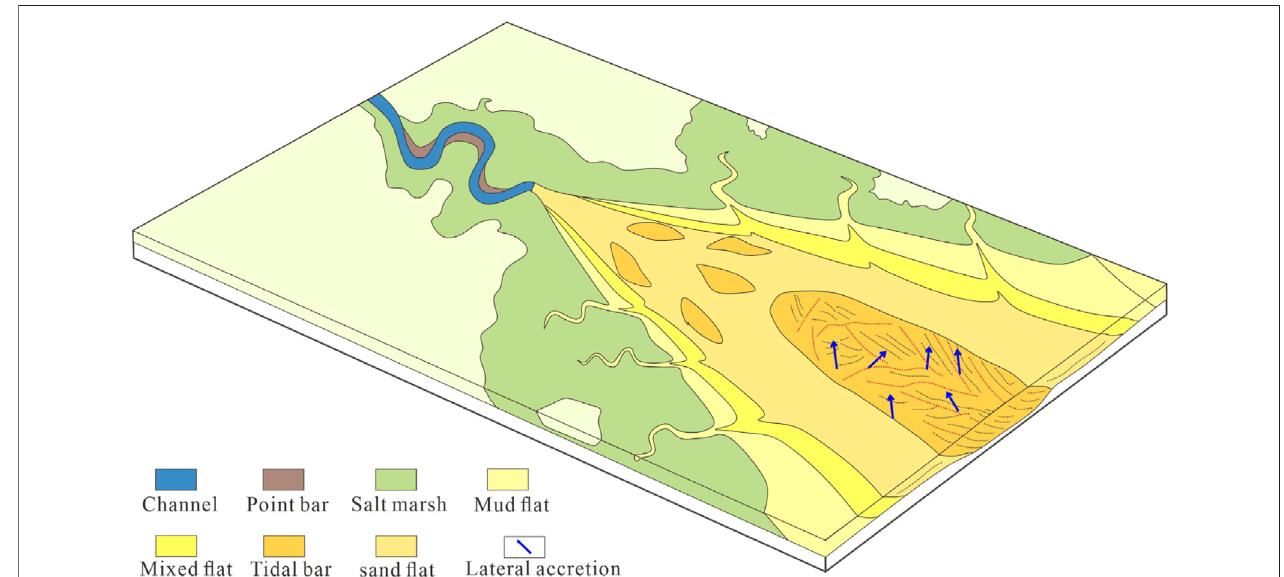
FIGURE 11 | The horizontal distribution pattern of the